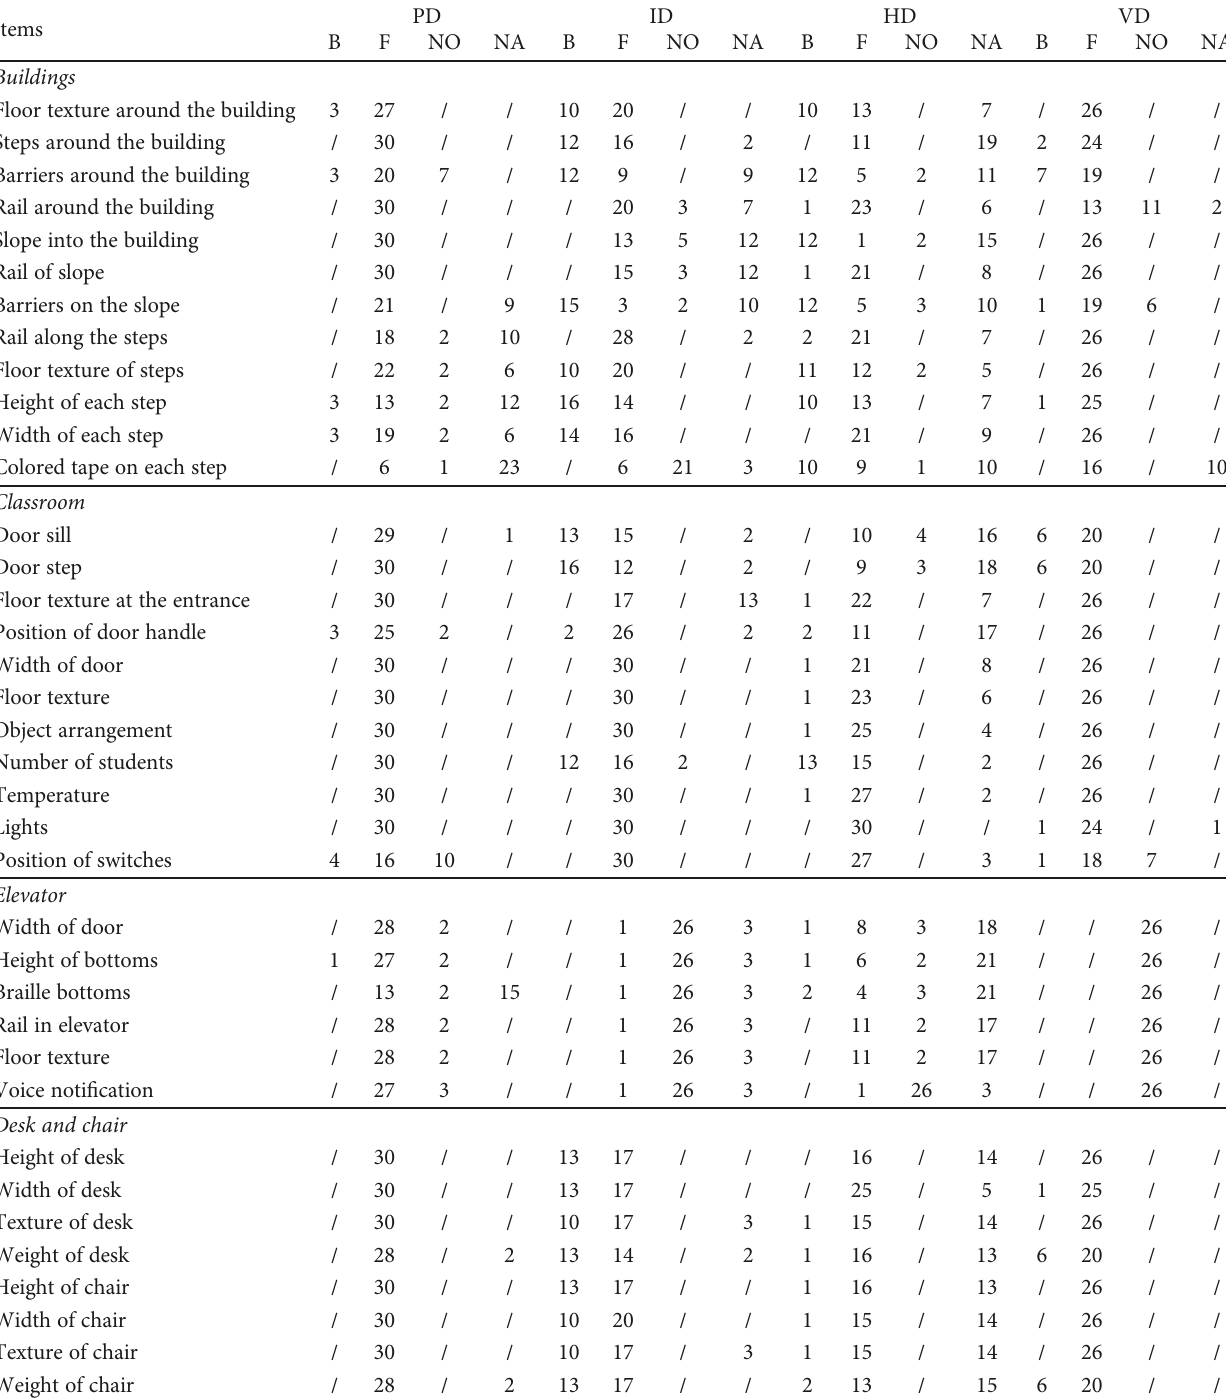
Table 8: Facilitators and barriers of the physical